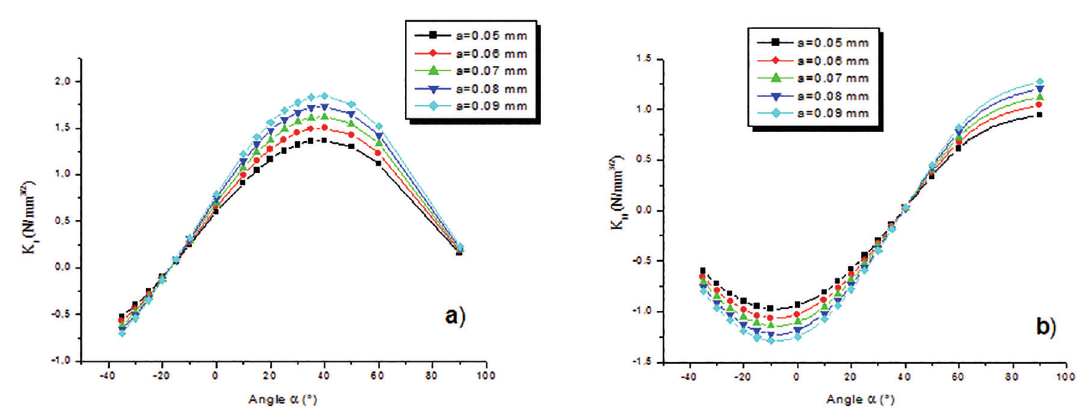
evolution and b) K I II